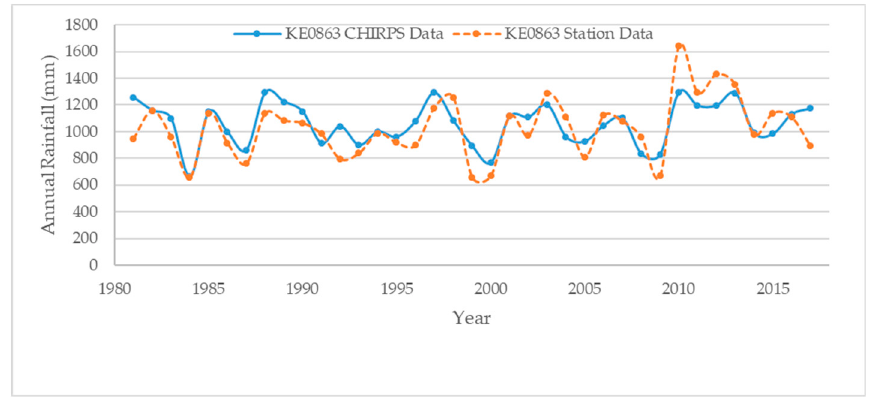
Figure 6. Comparison between CHIRPS and observed rainfall data on annual time series.